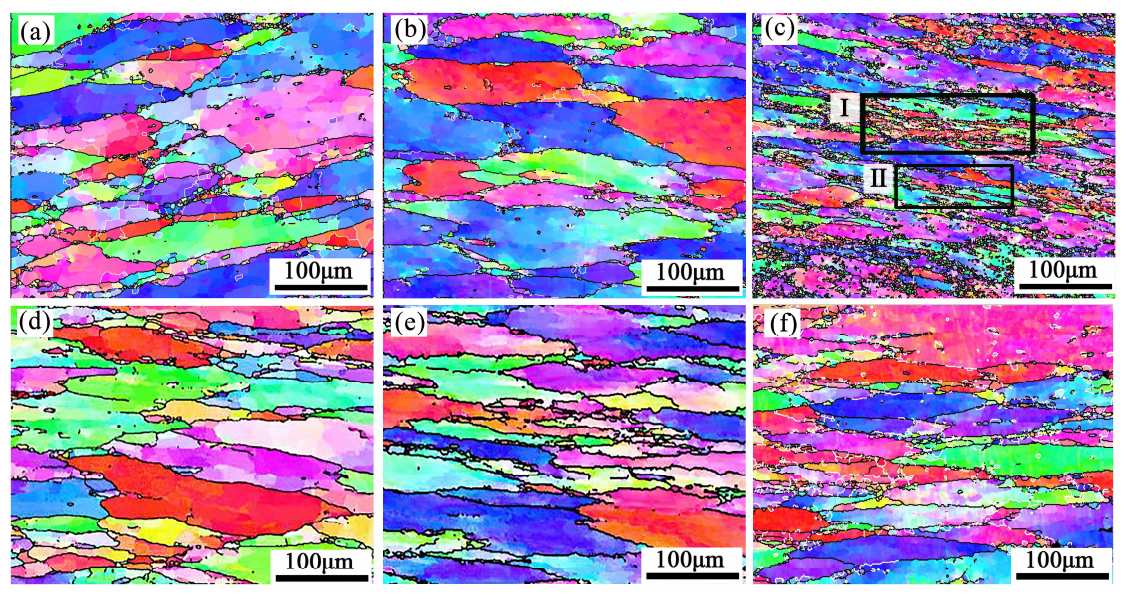
Figure 13. EBSD-IPF maps of the specimens deformed at 380 °C : ( a ) 0.01 s −1 , ( b ) 0.1 s −1 , ( c ) 1 s −1 and deformed at 440 °C : ( d ) 0.01 s −1 ( e ) 0.1 s −1 , ( f ) 1 s −1 .